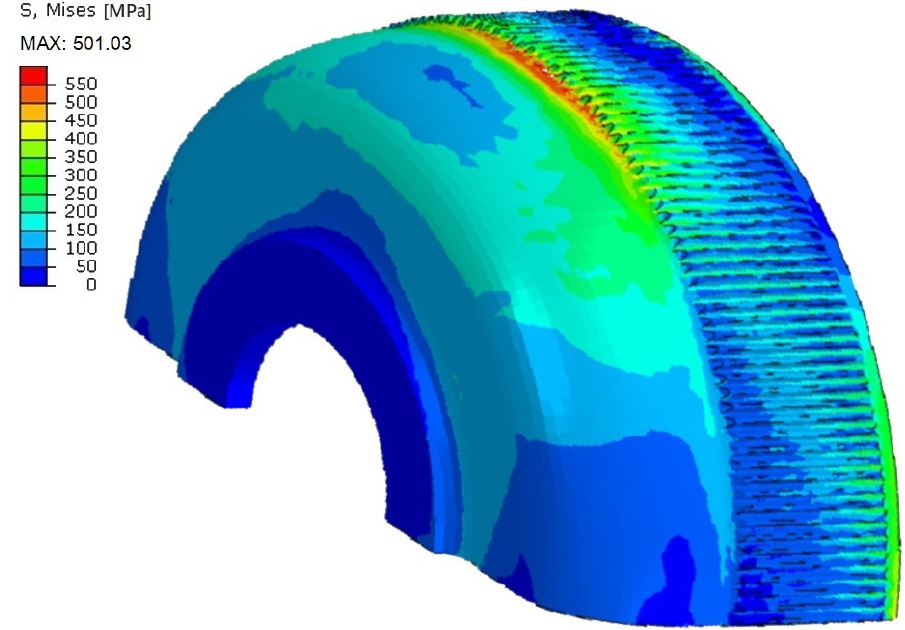
Figure 13. The distribution of the stresses in the flexspline model—variant IX. In other areas of the flexspline, for example, at the bottom, the stress values are also on a safe level and are below 100 [MPa]. It can be assumed that the construction of